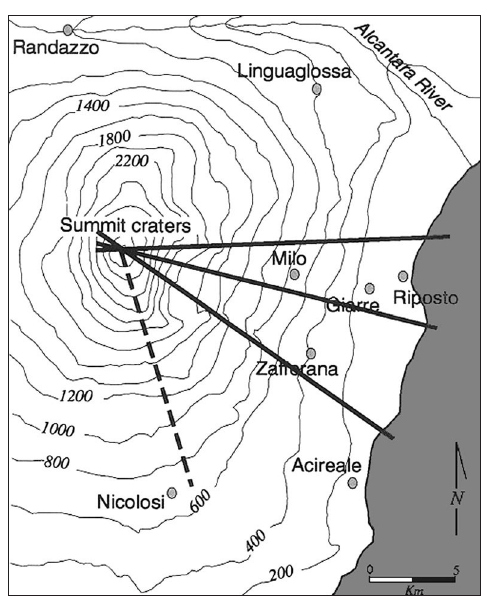
Fig. 1. MVRSS « Sicily 1997 » campaign MIVIS fl ight lines over Mt. Etna. Solid lines: MIVIS fl ights over the volcanic plume (one along the plume axis and two on each side). Dashed line: MIVIS fl ight over the ground- based measurement sites.